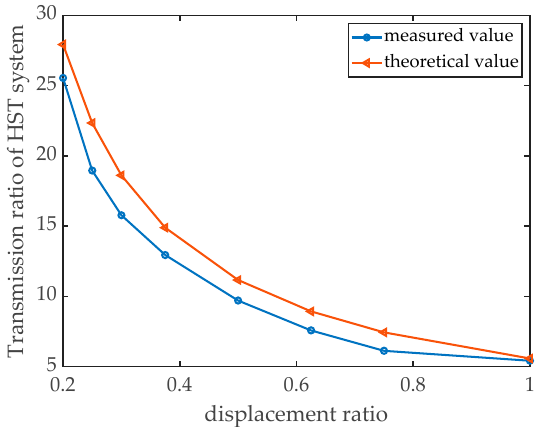
Figure 8. Results of the comparison of the theoretical value and the measured value of the HST adjustable speed transmission characteristics of the tractor.